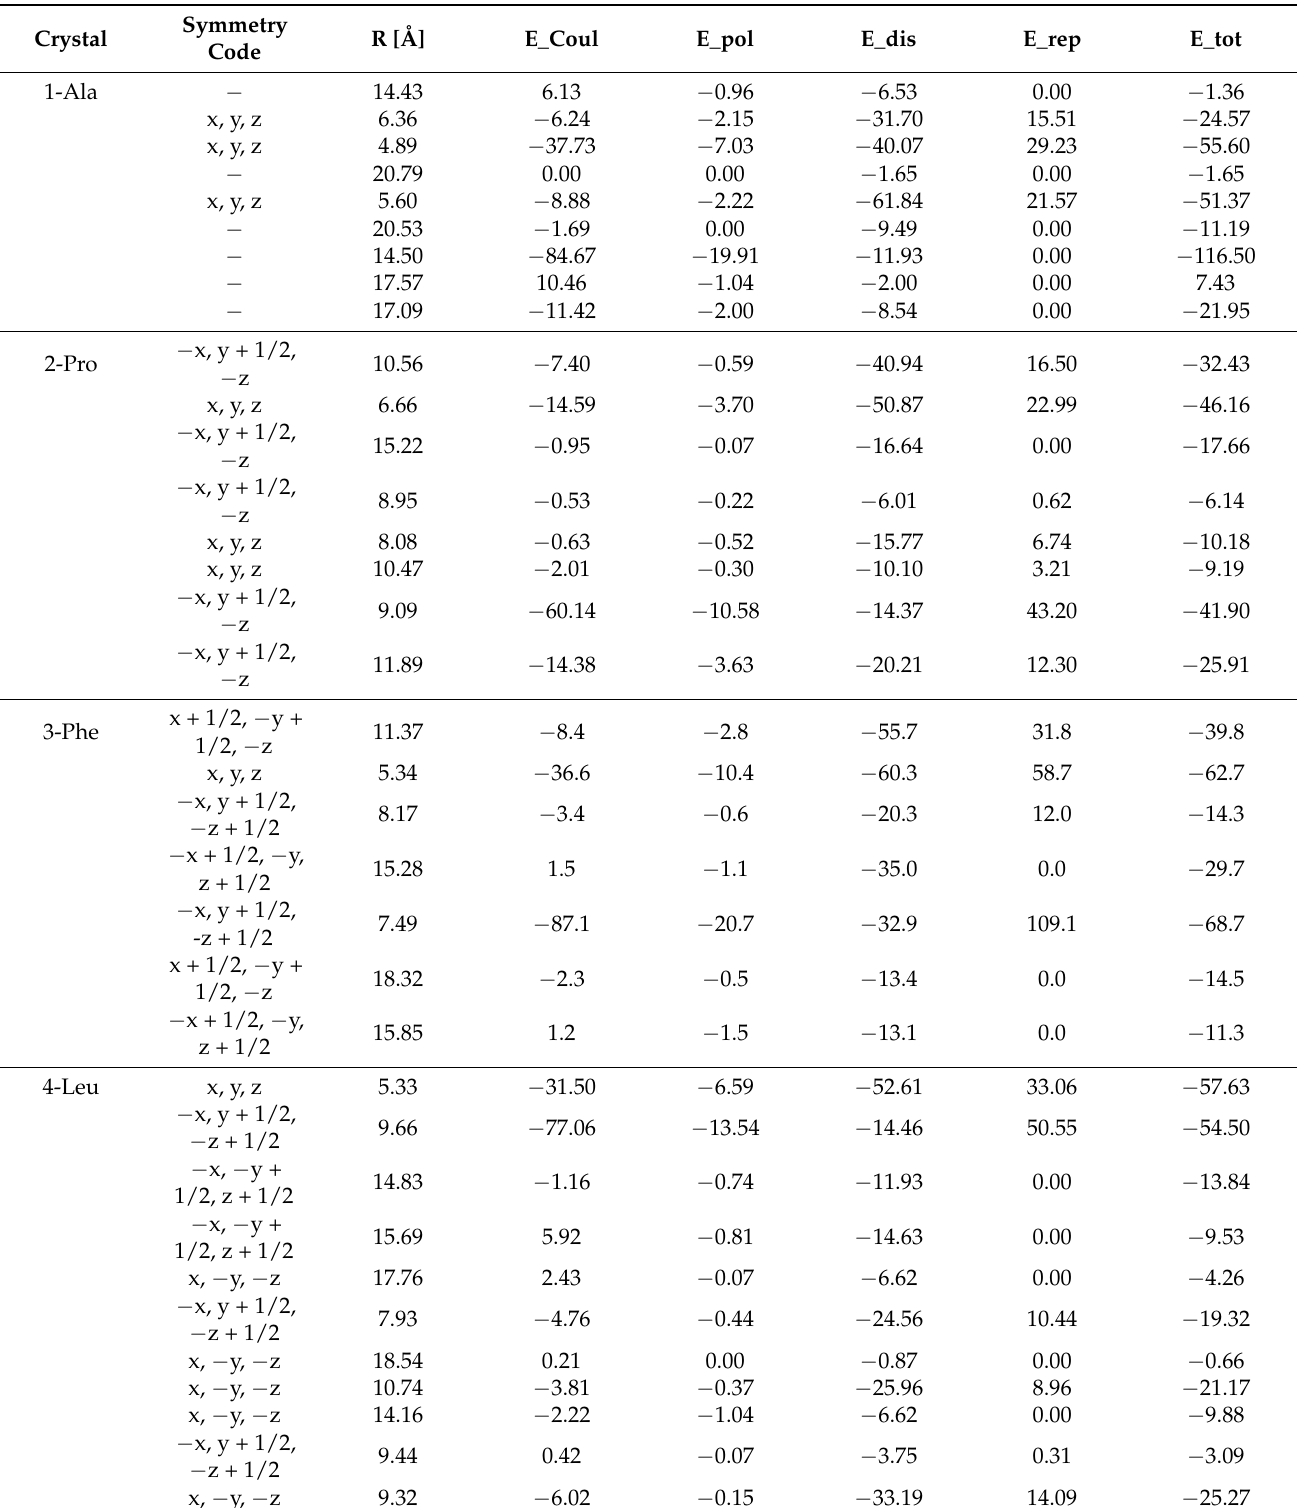
Table 1. Intermolecular energies calculated by CrystalExplorer at CE-B3LYP/6-31G(d,p) level in kJ/mol scaled by factors 1.057, 0.74, 0.871, and 0.618 for coulombic, polarization, dispersion, and repulsion energy terms, respectively, according to Mackenzie et al.